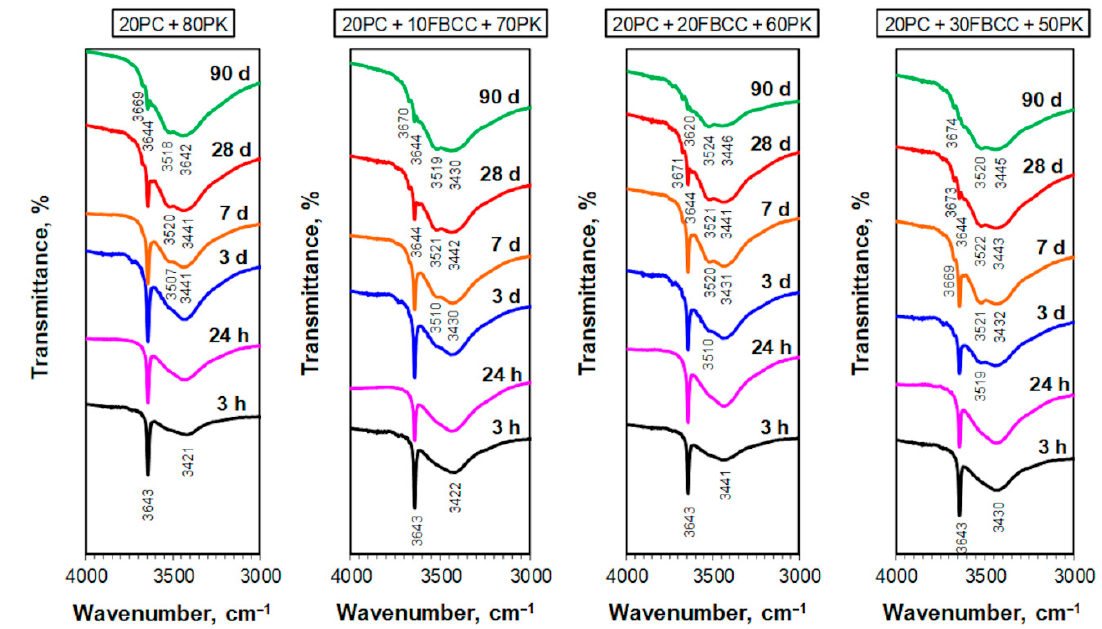
Figure 12. IR spectra for blended four-component binders after different times of hydration (at wavenumber scale from 3000 to 4000 cm − 1 ).